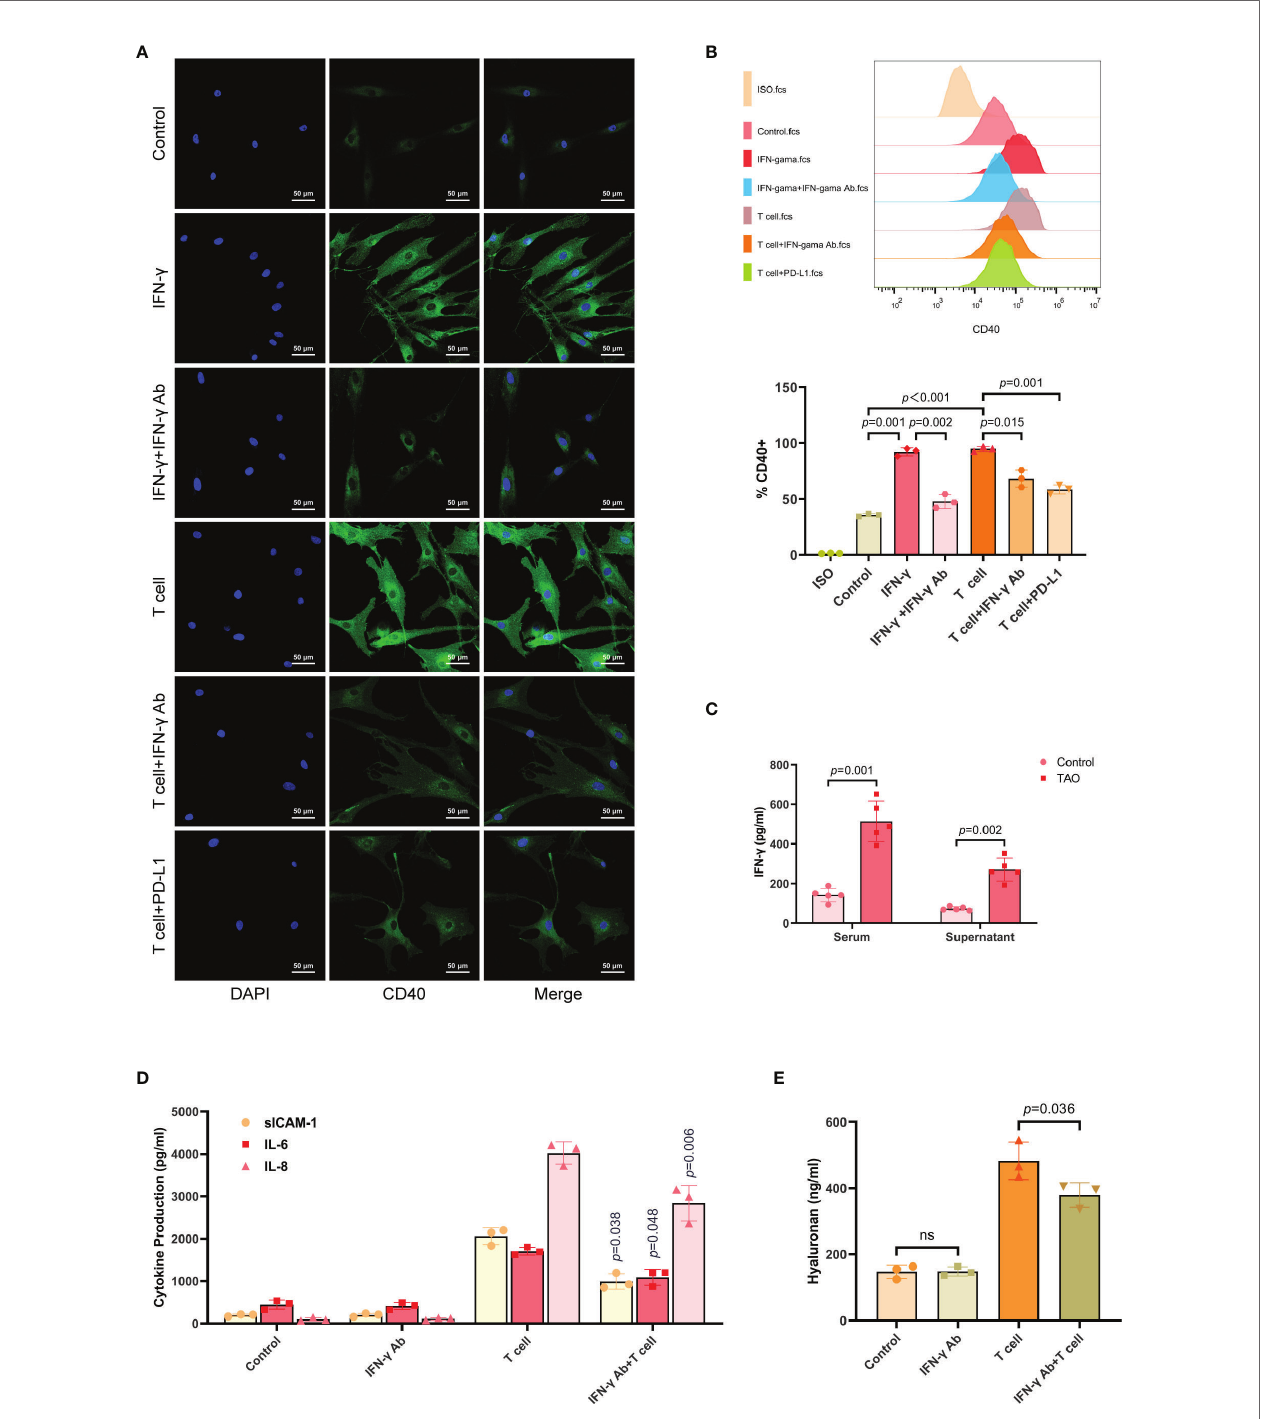
FIGURE 4 | T cells up-regulated the expression of CD40 in TAO-OFs by secreting IFN- g . (A, B) TAO-OFs were stimulated with PBS, IFN- g (100 U/mL), IFN- g combined with IFN- g neutralizing antibody (1 ug/mL), autologous T cells (OFs: T cells = 1: 10), T cells combined with IFN- g Ab, and T cells combined with PD-L1 for 24 hours, respectively. And TAO-OFs were subjected to IF (A) and FCM (B) for CD40 expression. (C) Comparison of IFN- g concentration in serum and lymphocyte culture supernatants between TAO patients and negative controls by ELISA. Lymphocytes were cultured in RPMI 1640 containing 10% FBS for 72 hours. (D, E) TAO-OFs were stimulated with PBS, IFN- g Ab (1 ug/mL), autologous T cells, and T cells combined with IFN- g Ab for 48 hours, respectively. And the supernatants were subjected to ELISA for sICAM-1, IL-6, IL-8, (E) and HA (D) production. Data are expressed as mean ± SD of three or more repetitions. ns, no signi fi cance. Representative of three or more independent experiments using cells from a different